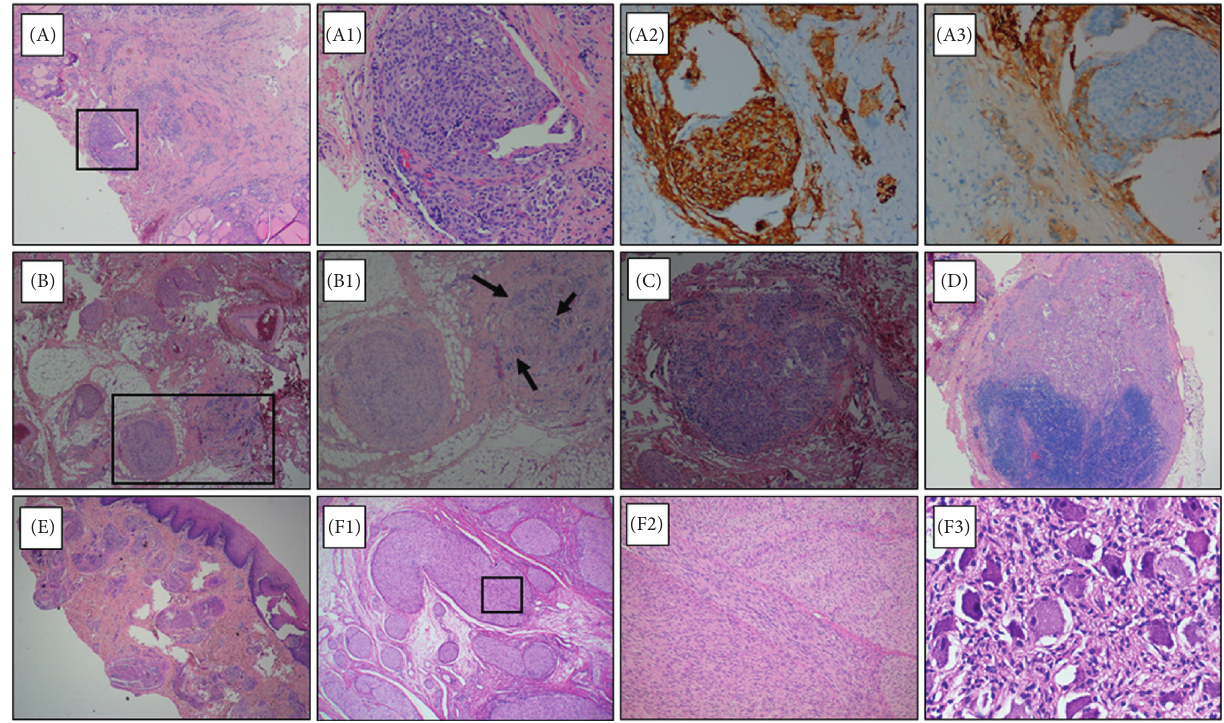
Figure 2: Histology of MTC and other lesions. Panels A and A 1 : MTC hematoxylin/eosin staining, magnification 2X and 10X, respectively. Panels A 2 and A 3 : positive anticalcitonin immunostaining (10X) and negative antithyroglobulin immunostaining (10X) confirming the diagnosis of MTC. Panels B and B 1 : MTC infiltrating the perithyroid gangliar tissue, as indicated by the arrows (panel B, 2X, panel B1, 4X). Panel C: MTC vascular invasion with a neoplastic embolus (4X). Panel D: central compartment lymph node metastasis (2X). Panel E: hematoxylin/eosin staining of ganglioneuromatosis in the mucosal neuromas of the mouth excised during surgery (2X). Panel F 1 : low-power view of the pelvic plexiform neurofibroma. Panel F 2 : at higher power, the neurofibroma component consists of a uniform population of bland spindle cells with wavy elongated nuclei set in a fibrillary matrix. Panel F 3 : the ganglioneuromatosis elements, which consist of large ganglion-like